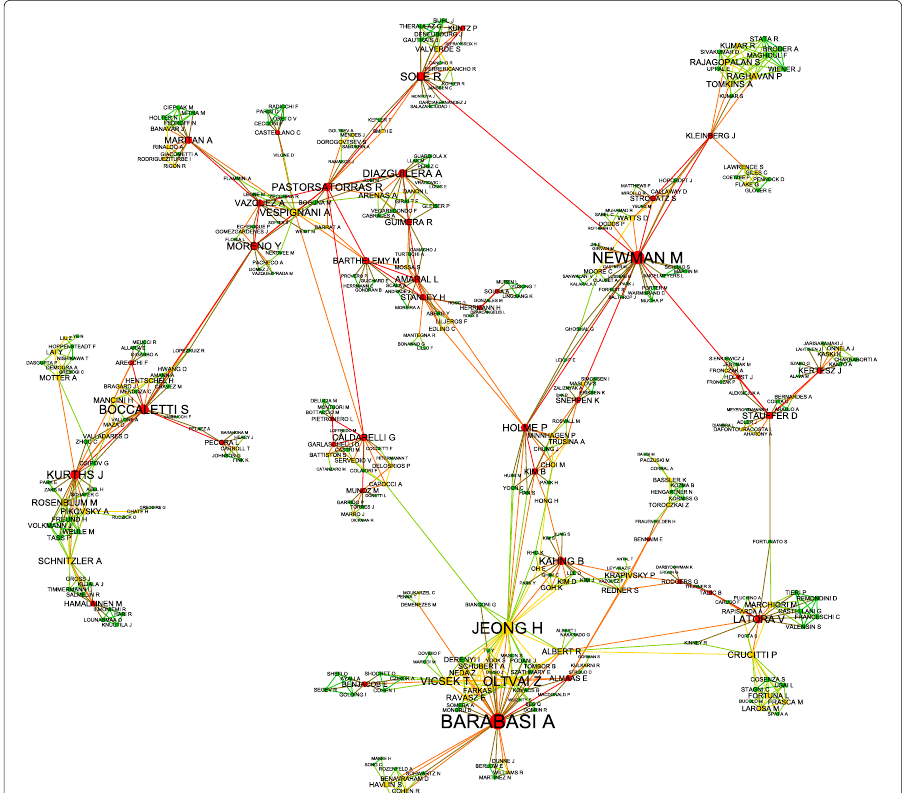
Fig. 19 The largest connected component of Net Science network. The researchers represented by strongly-prominent nodes (red) are independent on the other people in the network. Key researchers can be recognized by their high degree, e.g., Barabási and Newman. There are also weakly-prominent nodes (yellow) with a high degree, e.g., Jeong, Oltvai, and Vicsek. However, all of them are one-way dependent on